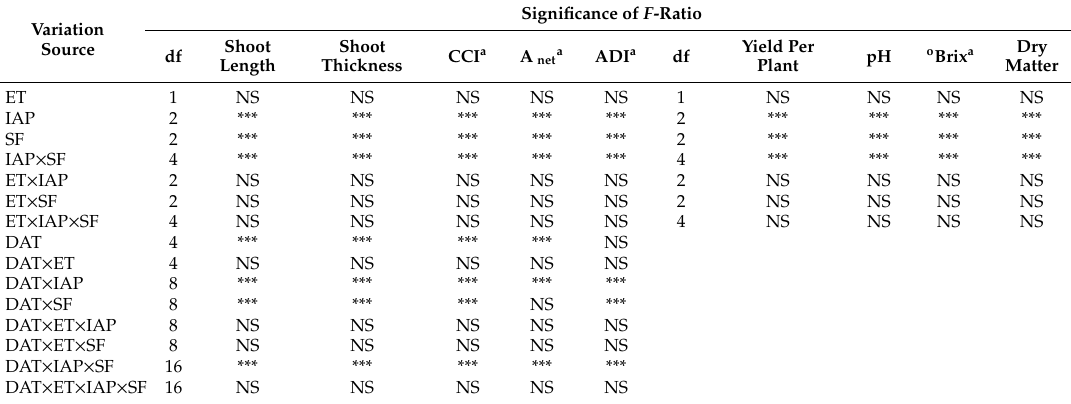
Table 5. Results of analysis of variance applied on growth and physiological parameters, on productivity and on quality parameters of tomato, examined after the incorporation of spearmint and oregano into the soil and during the decomposition process. F -ratios’ significance are given for the e ff ects exerted by the experimental time (ET, the experiment being repeated twice), the incorporated aromatic plant (IAP), the species of fungi (SF) and the days after the transplantation (DAT).